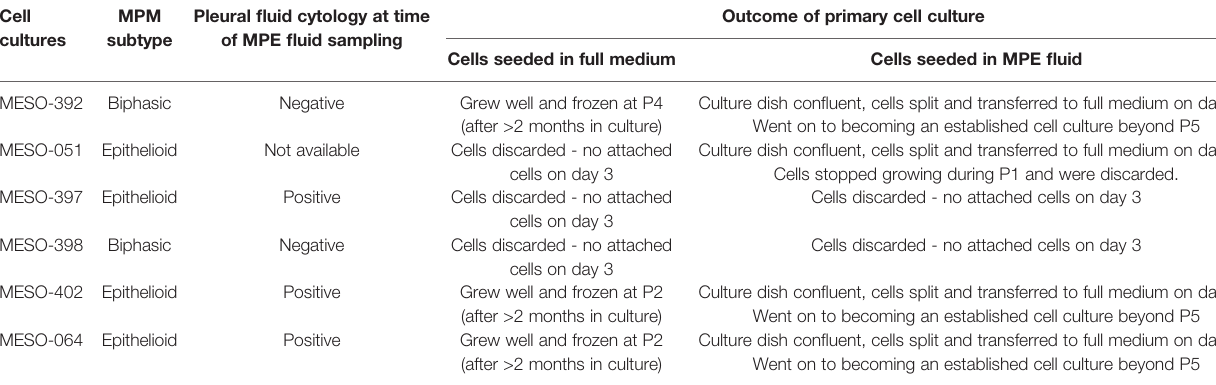
TABLE 2 | Shows the outcomes of the MPM primary cell culture in MPE fl uid and in full medium. Cell